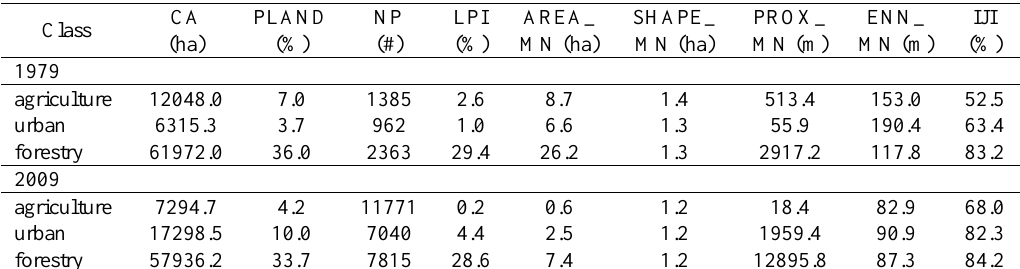
Table 5. Metrics of landscape structure for selected indices at the class level, 1979 and